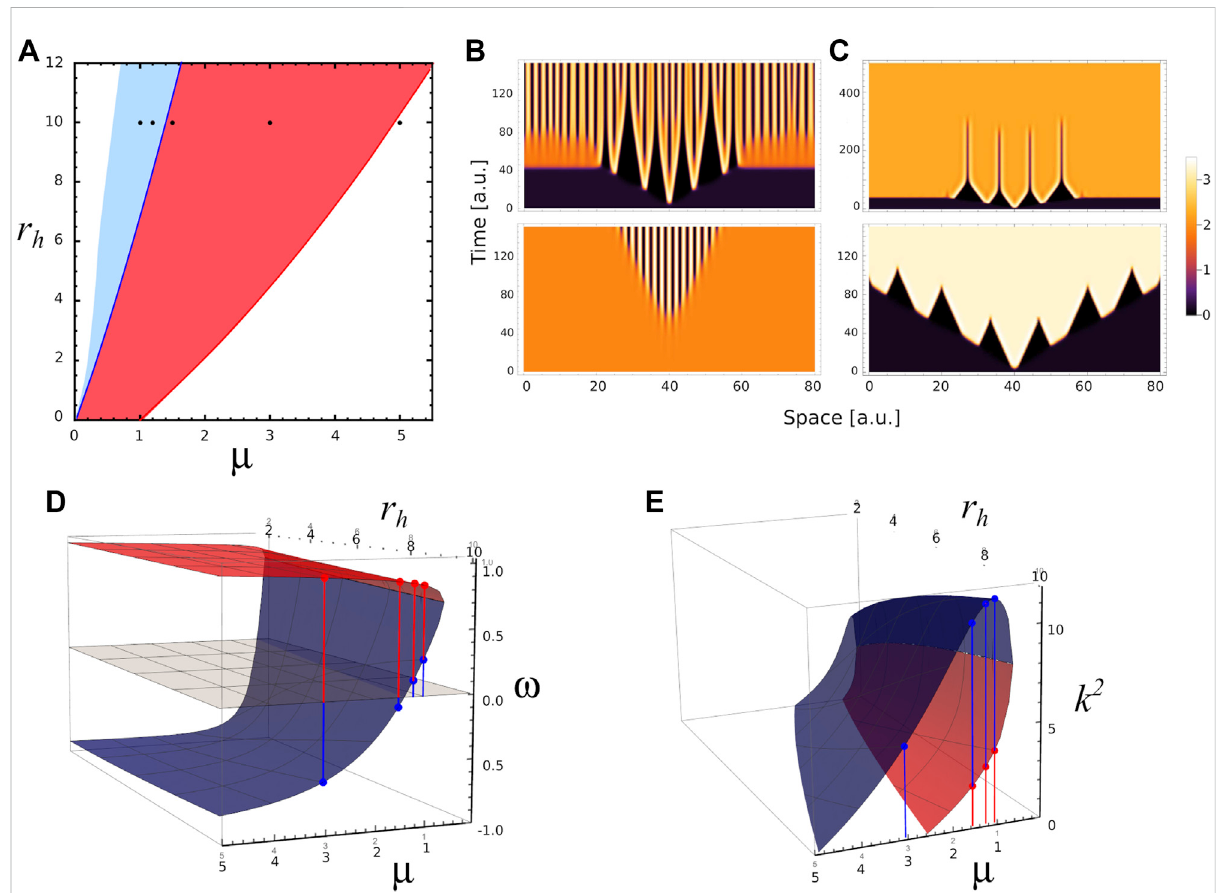
FIGURE 4 Different spatial scales. (A) 2D phase diagram shows the parameters region where the system presents stable Turing patterns (blue area) and unstable or transient Turing patterns (red area) for r a =6.0. Black dots correspond to different triplet of parameters values ( μ , r a , r h ) where numerical simulationwereperformed: P 1 =(1.0,6,10), P 2 =(1.2,6,10)intheTuringpatternregion, P 3 =(1.5,6,10), P 4 =(3.0,6,10)inthetransientTuringpatternregion,and P 5 =(5.0,6,10) in the region for uniform distributions. (B) 1-D numerical simulations showing the temporal evolution of activator concentration distribution a forparametersvalue P 2 withtwodifferentinitialconditions.Top(bottom)panelcorrespondstothetemporalevolutionwhen fi xedpoint S 1 ( S 2 ) is perturbed by a small perturbation at x =40, note the different spatial scales of patterns on the panels. The temporal evolution of a for parameters values P 1 , P 3 and P 5 are shown in Supplementary Figure S2. (C) 1-D numerical simulationsshowingthe temporal evolutionof a forparameters values P 3 (toppanel)and P 4 (bottompanel)whenthe same fi xedpoint S 1 is perturbed at x = 40. (D) Red and bluesurfacescorrespondto ω -valueasfunction of μ and r h associatedwith fi xedpoints S 1 and S 2 ,respectively. (E) k 2 -valuesasfunctionof μ and r h associatedwith S 1 (redsurface)and S 2 (bluesurface).Inboth panels D and E, r a =6.0, and the red and blue dots indicate ω and k 2 values for P 1 , P 2 , P 3 and P 4 in each